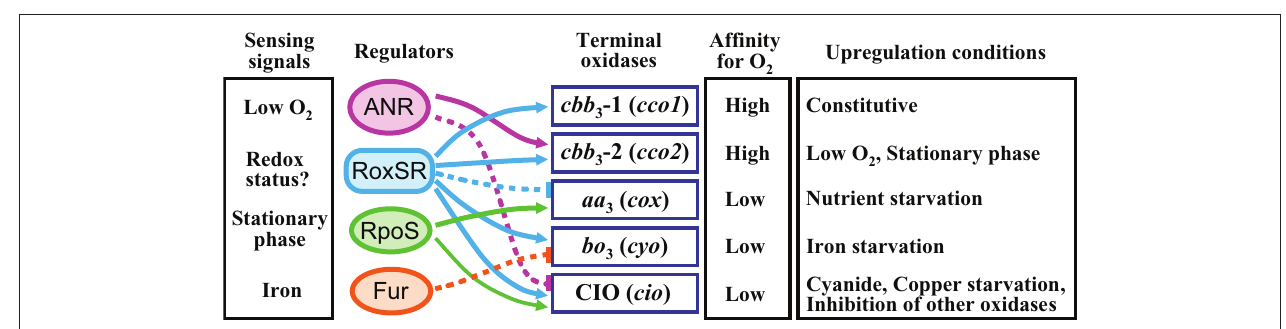
oxidase and the 3